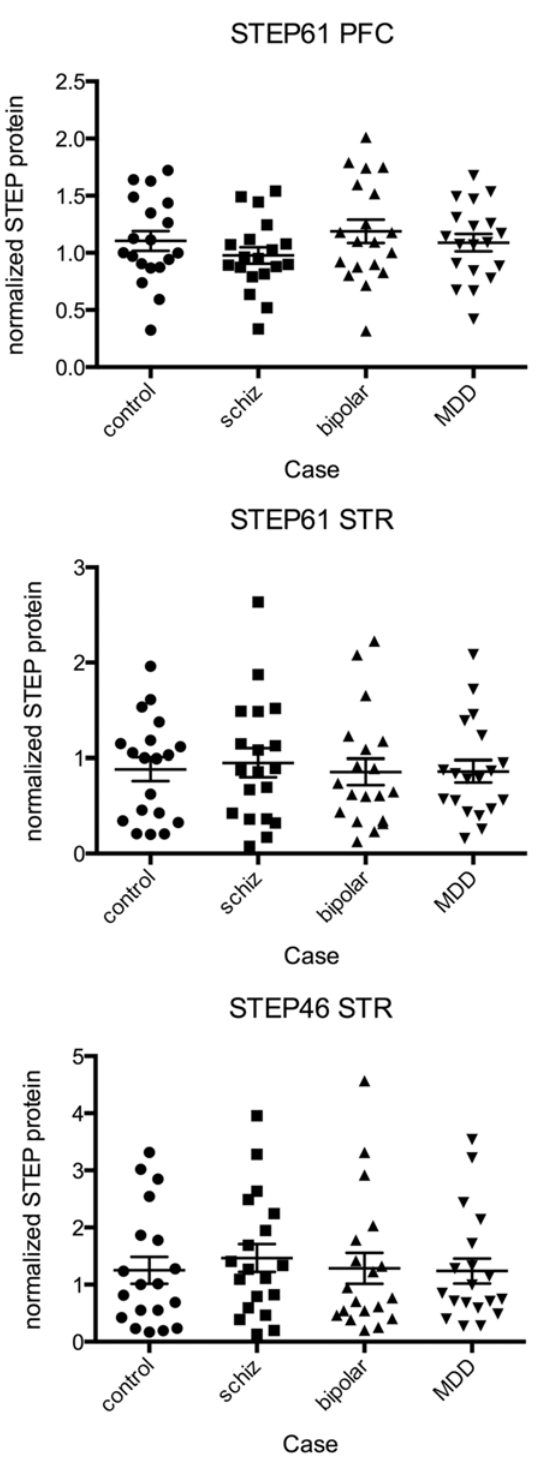
Fig 3. Quantitation of STEP protein levels in human postmortem brain tissue from subjects with schizophrenia, bipolar disorder and major depressive disorder. STEP61 was quantified in Brodmann Area 46 (A) and associative striatum (B), and STEP46 was quantified only in associative striatum (C), as it was not present in the cortex. STEP levels were normalized to a cyclophilin loading control. Intensity values were scaled to the median of the control group. Each point on the graph represents a single subject (each subject was run on 3 separate gels, with 3 replicates per